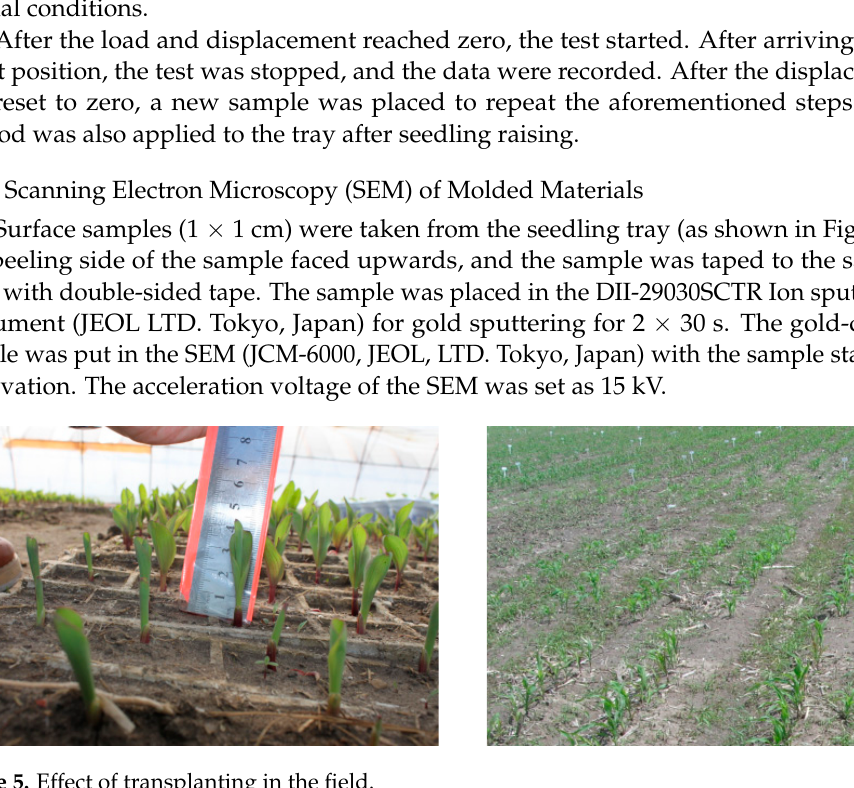
5 of 16 Figure 4. Failure analysis of three-point bending of a seedling tray.